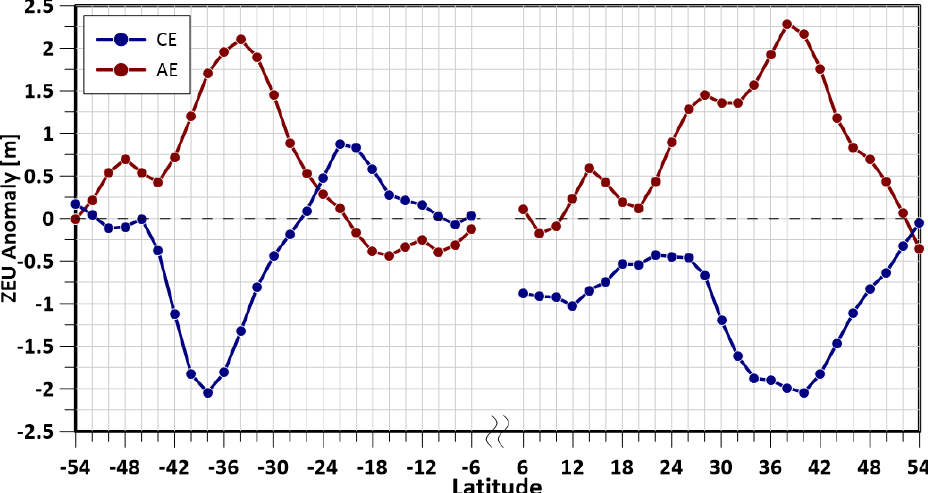
Figure 3. The variation of ZEU′ in the eddy inside with latitude. The ZEU′ of each 2° latitude band was averaged from 5°~55°.